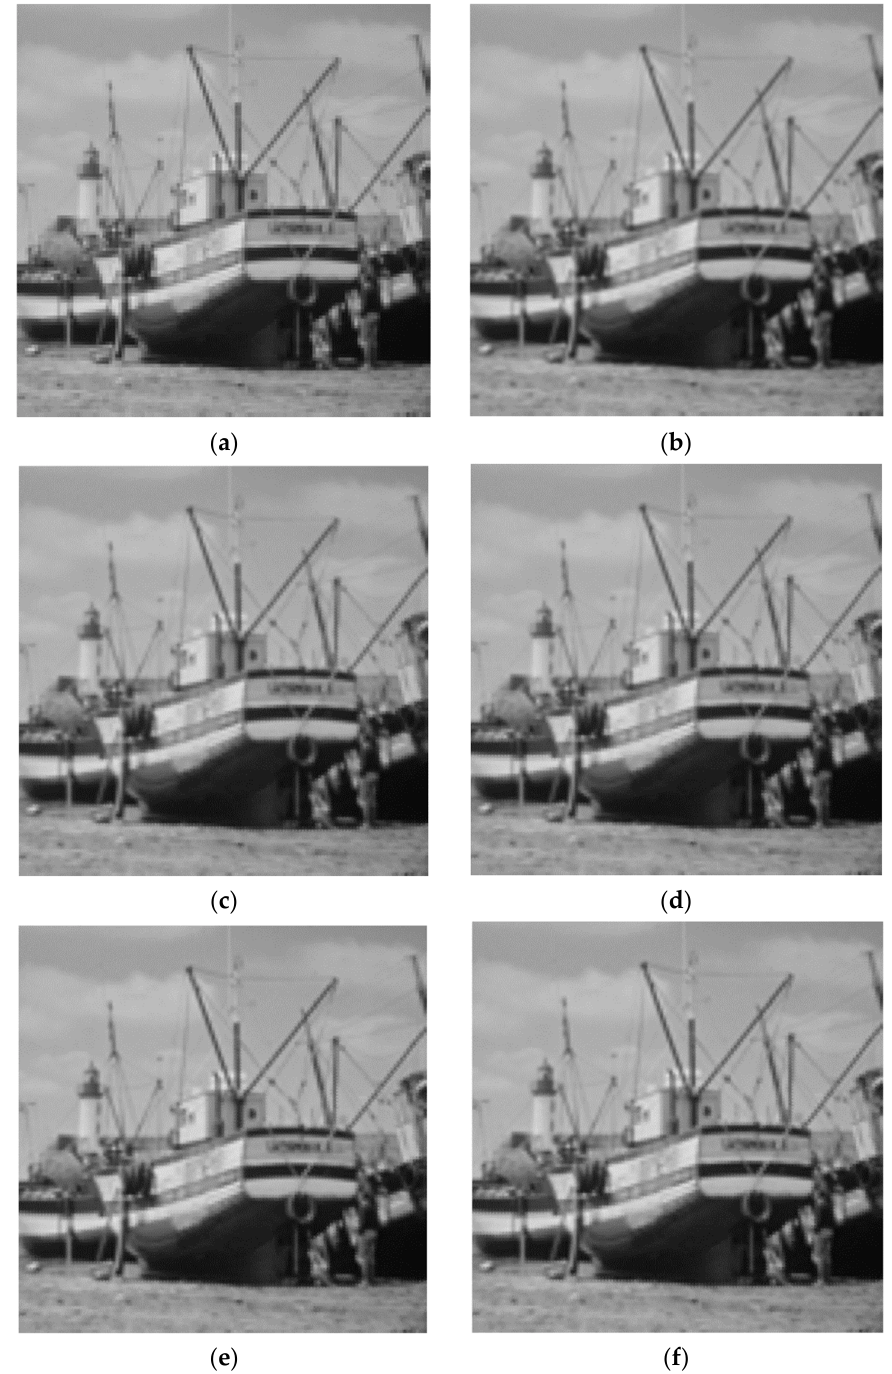
Figure 13. The interpolating image upscaling with a factor of two: ( a ) nearest neighbor; ( b ) bilinear; ( c ) bicubic; ( d ) bicubic Hermite; ( e ) Karim and Saaban [11]; ( f ) the proposed method.